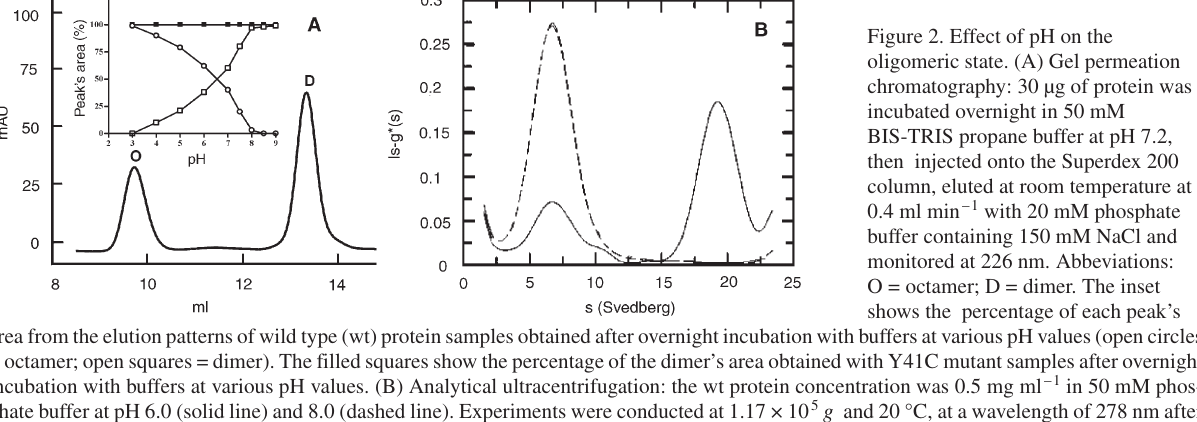
Figure 2. Effect of pH on the oligomeric state. (A) Gel permeation chromatography: 30 µg of protein was incubated overnight in 50 mM BIS-TRIS propane buffer at pH 7.2, then injected onto the Superdex